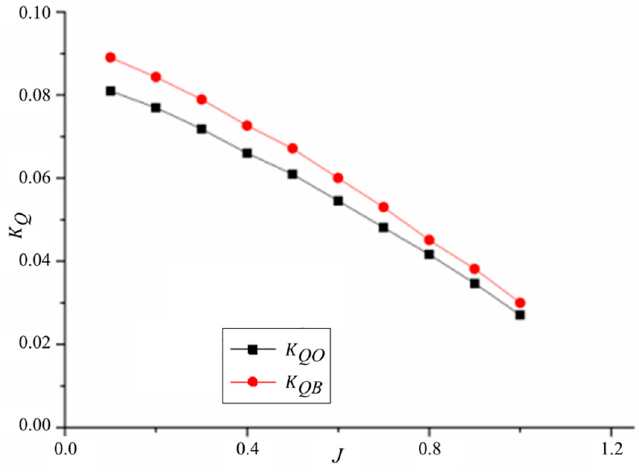
Figure 5. Torque coefficient of podded propulsor in self-propulsion and open water conditions.